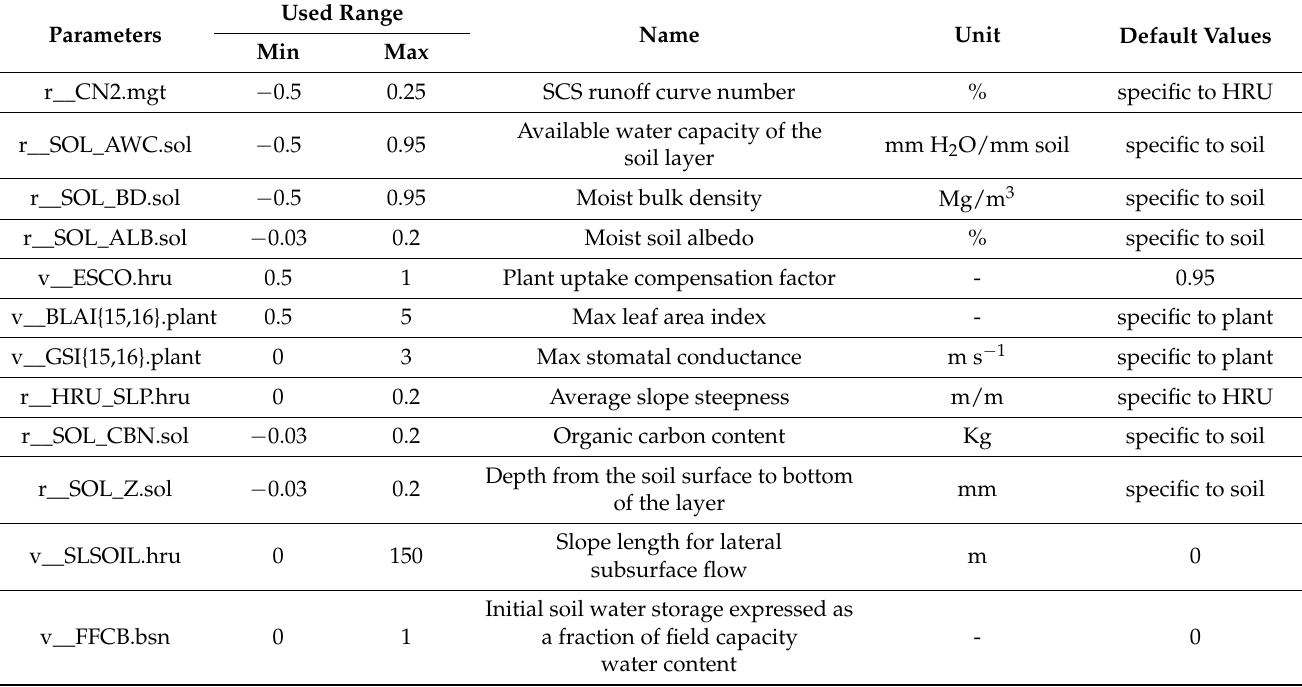
Table 5. SWAT calibration: 15 most influential parameters (15); type and range of the corrections and initial values assigned according to the SWAT